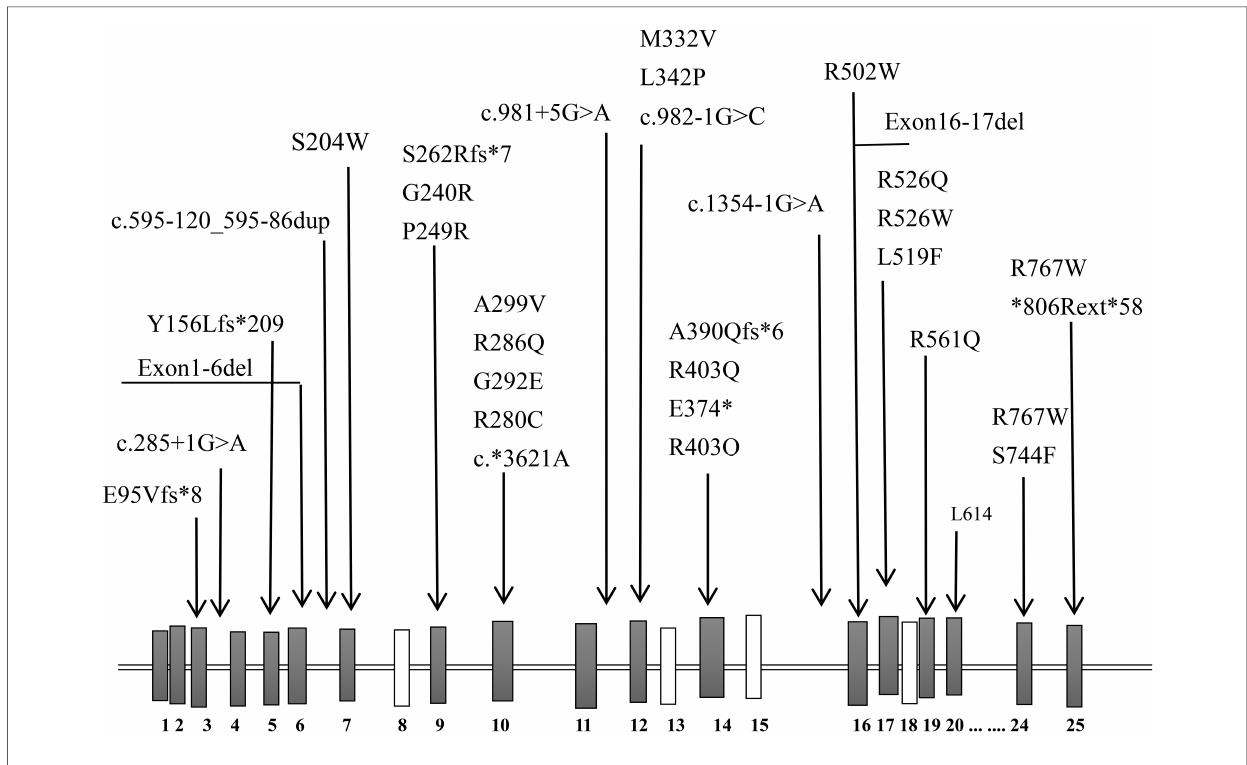
FIGURE 3 A sketch-map of the gene and location of reported variants of CLCN7